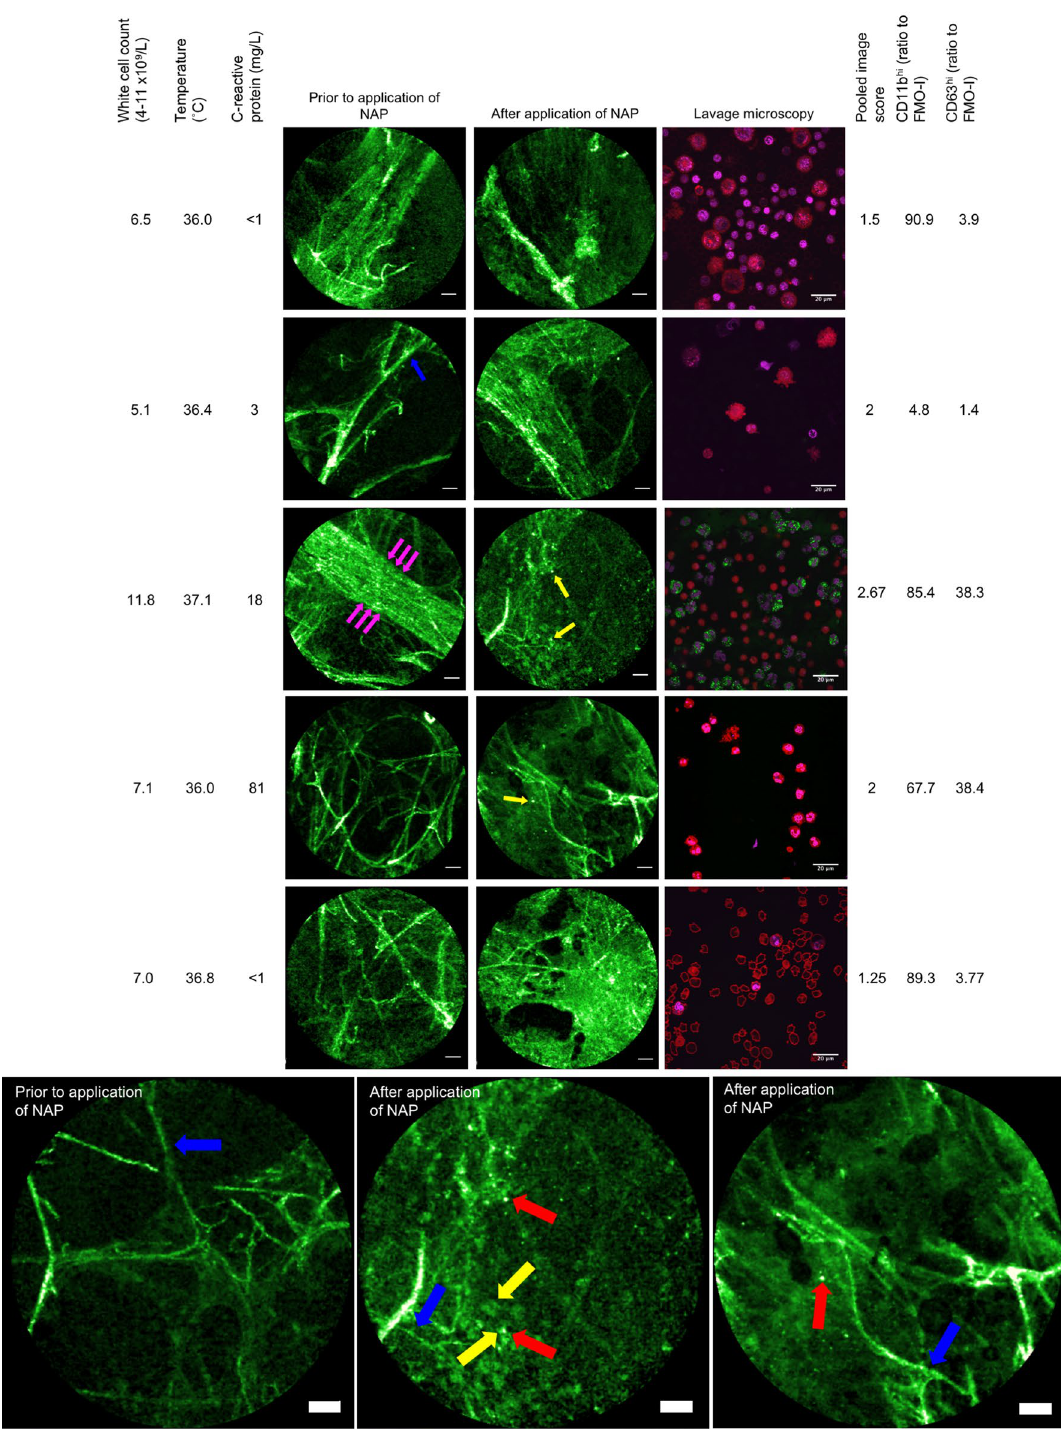
Figure 4. Representative OEM images from participants with bronchiectasis before and after the application of NAP are shown in the left-hand image columns. One participant received NAP but did not tolerate subsequent imaging, so five sets of imaging are shown. Blue arrows—alveolar wall, red arrow—punctate fluorescent NAP signal, purple arrows—pulmonary capillary. The labelling of relevant features is not exhaustive in these representative images. Laboratory confocal microscopy from the broncho-alveolar lavage is shown with each pair of OEM images. Red stain—Calcein red cytoplasmic stain. Purple stain—Styo62 nuclear stain. Green stain—material excited at 488 nm and emitting at 500–530 nm. Calcein red and Syto62 are applied after lavage harvest. Green fluorescent staining has taken place within the lung. Left hand side: selected clinical parameters from each participant are shown. Right hand side: pooled subjective blinded video analysis from two blinded experienced observers working independently is shown. 1—no suspicion of NAP signal, 2—suspicion of NAP signal, 3—positive NAP signal, 4—very positive NAP signal. Of the CD66b hi population in lavage, values for CD11b hi and CD63 hi cell surface markers as a ratio of the relevant isotype control are shown. Bottom row; larger example OEM images for inspection, description given with image. Scale bar OEM 50 µm, scale bar laboratory confocal microscopy 50